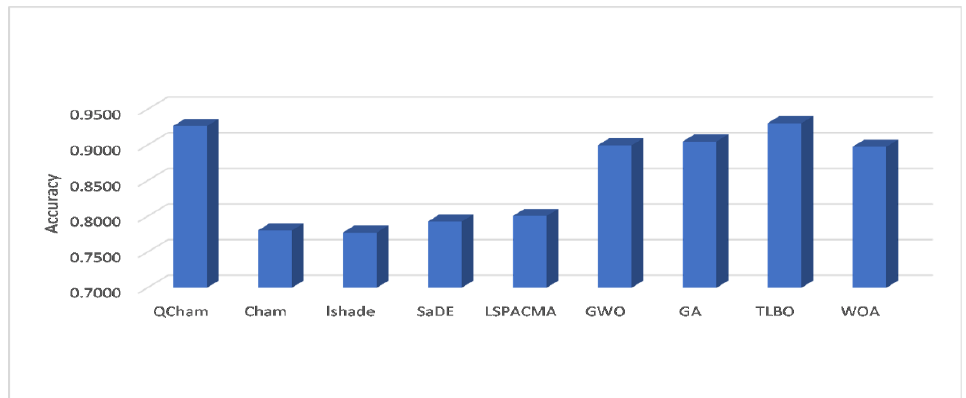
Figure 4. Average Accuracy of the models for all datasets studied.